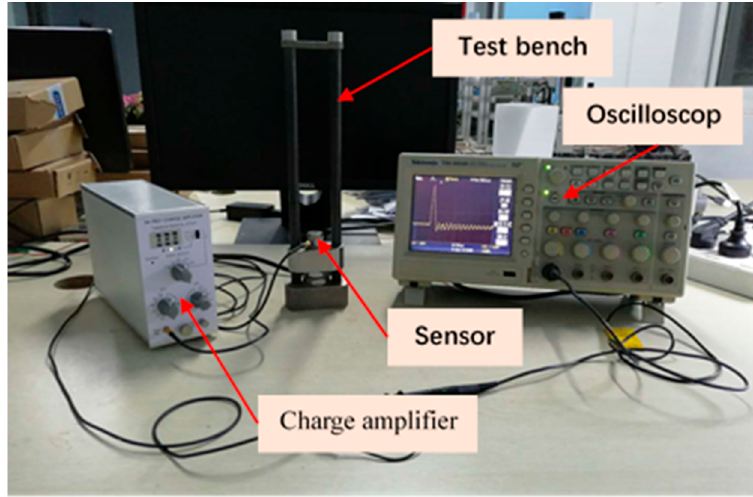
Figure 2. The schematic diagram of the drop test system under normal temperature conditions.